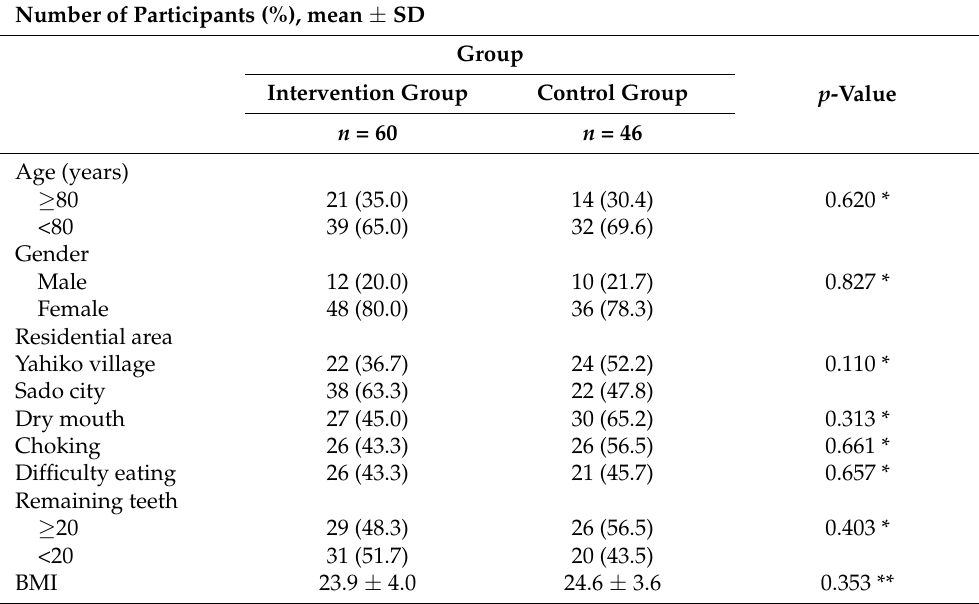
Table 1. Selected characteristics of the participants in the intervention and control